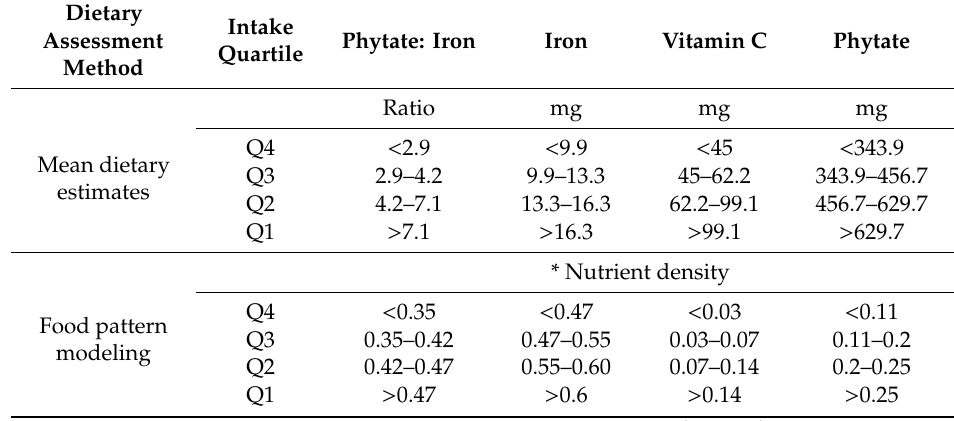
Table 5. Nutrient cuto ff s for receiver operating characteristic (ROC) curves by dietary assessment type.